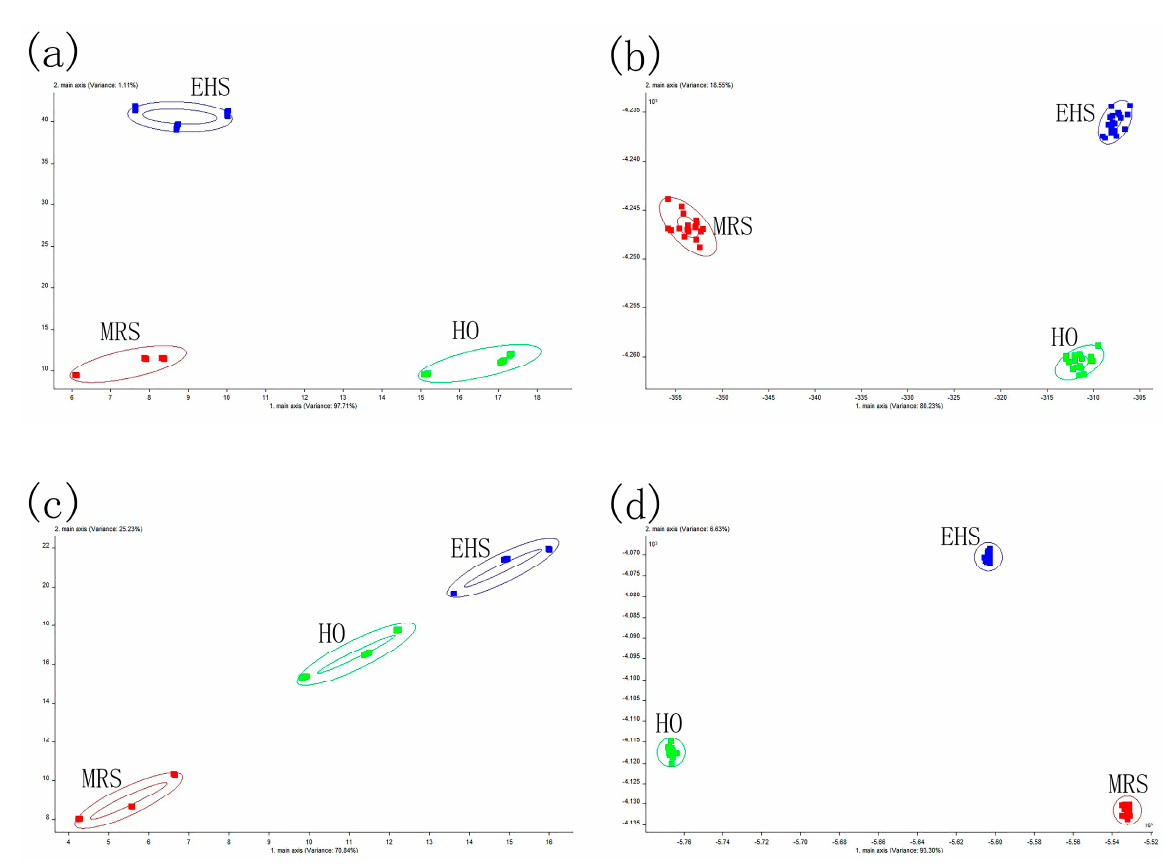
Figure 4. E-nose patterns: ( a ) PCA of crab legs, ( b ) LDA of crab legs, ( c ) PCA of crab bodies, and ( d ) LDA of the crab